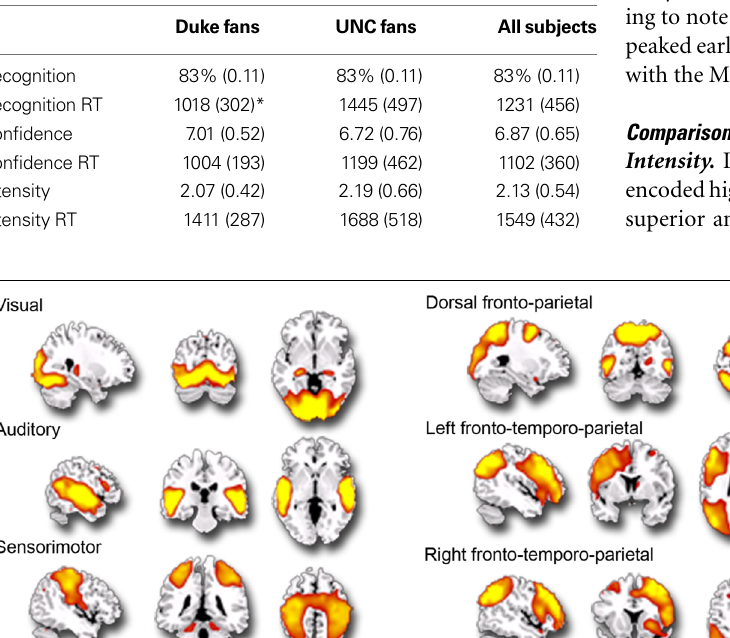
Table 1 | Mean (SD) behavioral data and reaction times (RTs, in ms) for recognition, confi dence, and intensity judgments for the old items as a function of self-identifi ed fan group (* indicates signifi cant group difference, p =